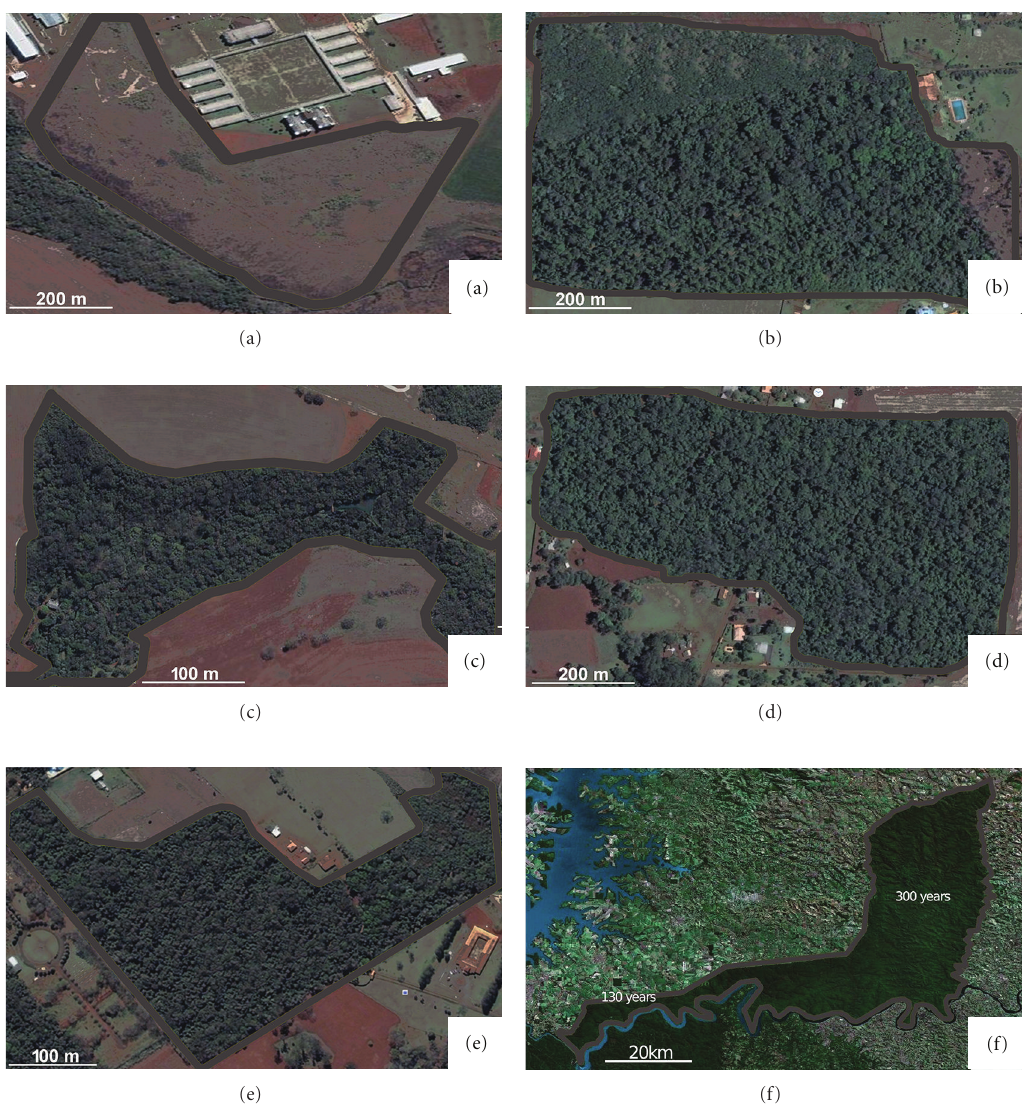
Figure 1: Study areas, with the following years of regeneration: (a) zero; (b) six; (c) fifteen, (d) thirty-five; (e) seventy; (f) 130 and 300 years (Iguac¸u National Park). Source: [28]. For additional information, see Table 1.